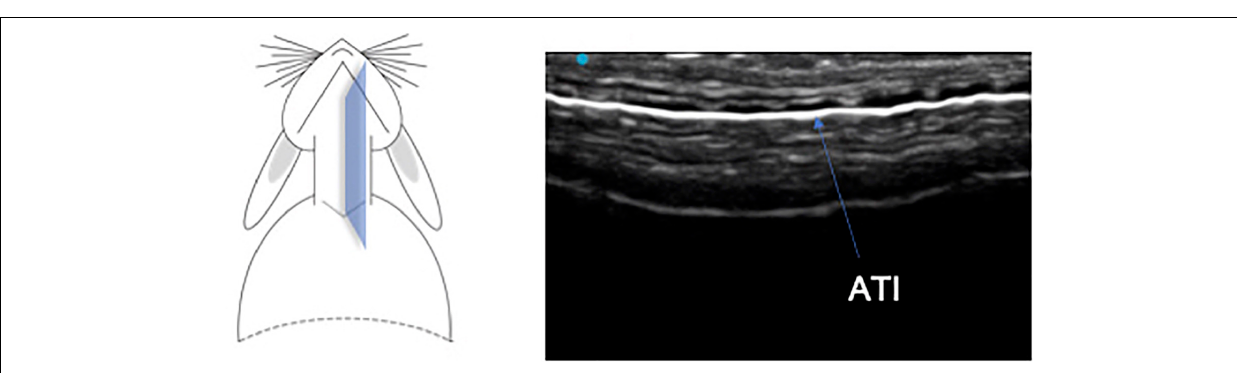
FIGURE 3 | Longitudinal plane of cervical trachea. ATI, air-tissue